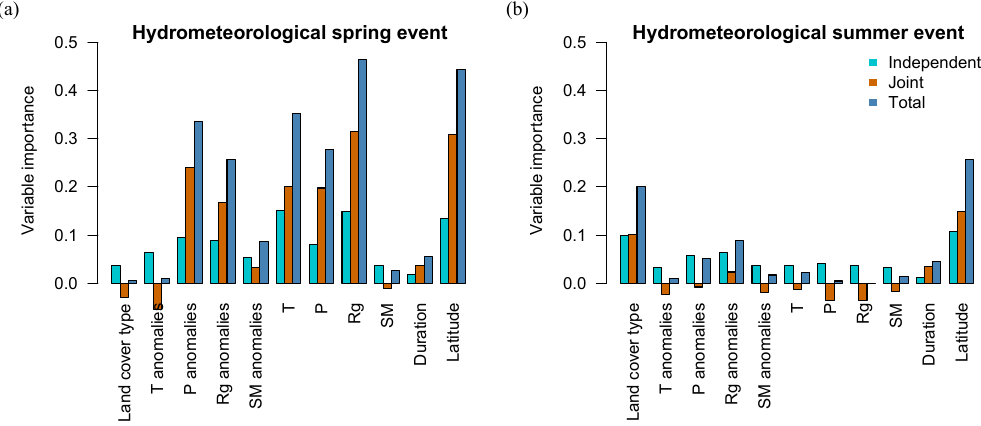
Figure D1. Independent, joint, and total contribution of the factors explaining (a) GPP response during the hydrometeorological spring event 1 and (b) during the hydrometeorological summer event. Used abbreviations are T (temperature), P (precipitation), Rg (radiation), and SM (soil